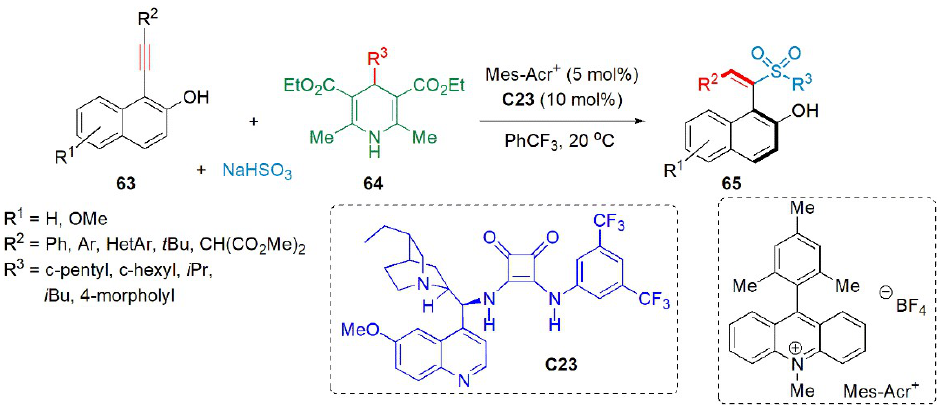
Figure 24. Enantioselective sulfonylation of 1-(arylethynyl)naphthalen-2-ols